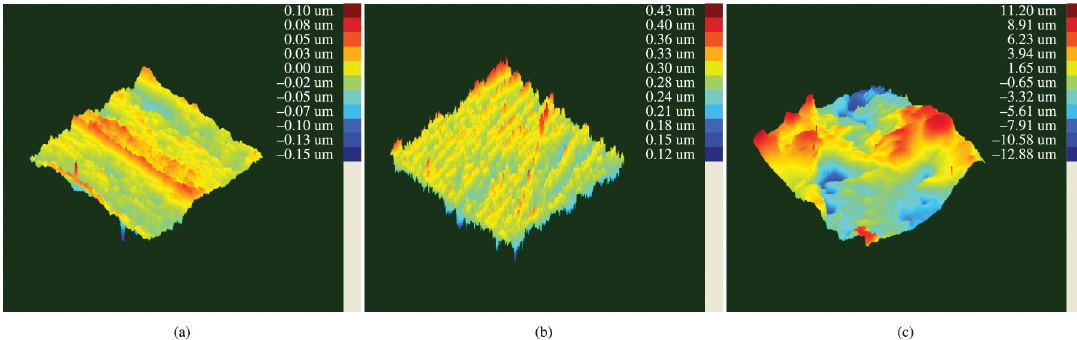
Figure 1. SEM of the samples: (a) Bare, (b) Sanded and (c) Shot peening.